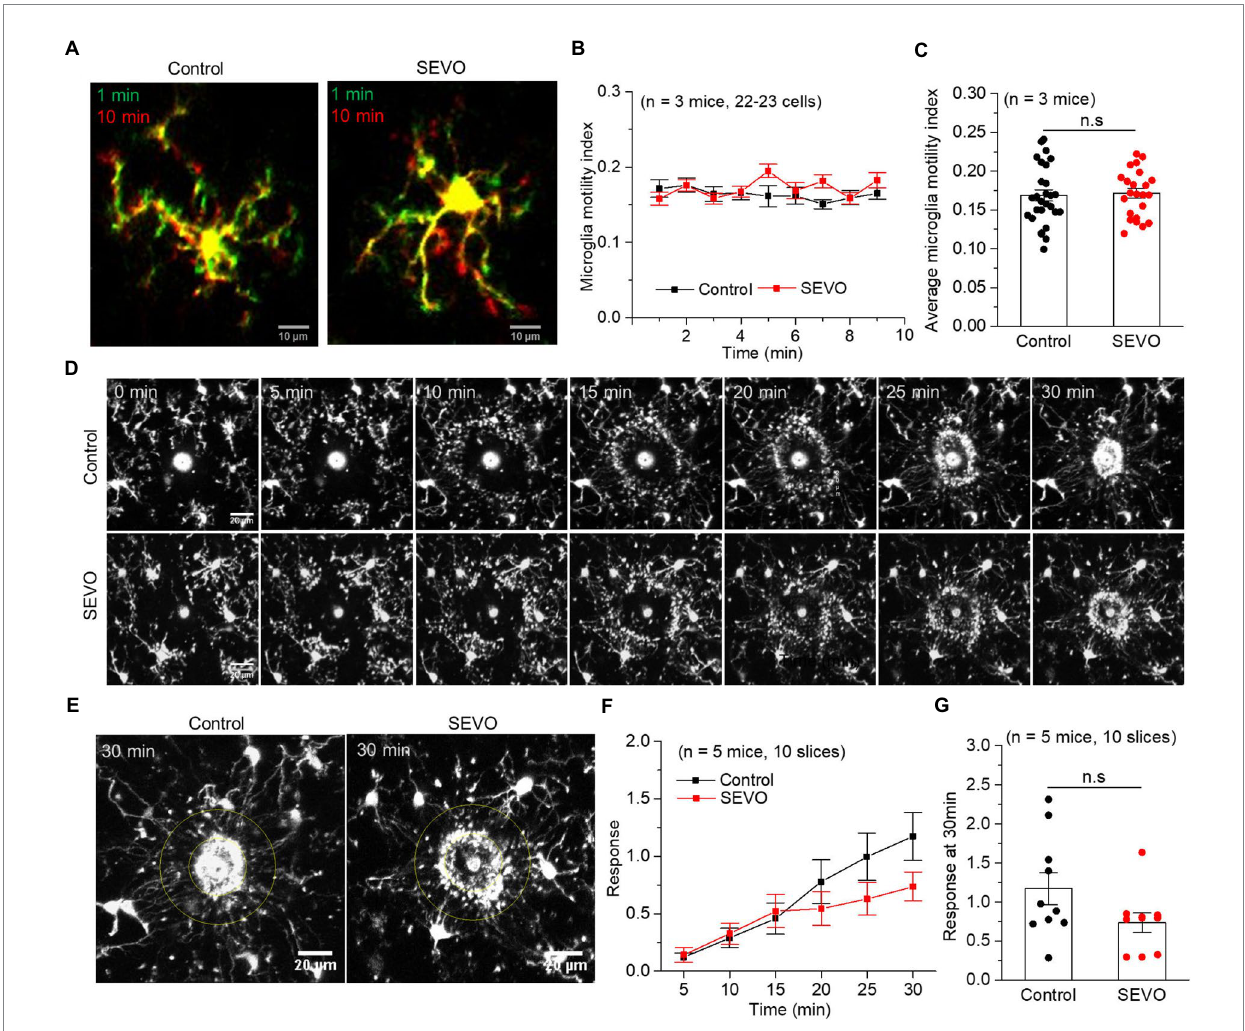
FIGURE 5 Microglia surveillance capability in resting and stimulated states 14 days after prolonged neonatal sevoflurane exposure. (A) Representative images of microglia in acute brain slices of CX3CR1-EGFP mice during 10-min imaging in the resting state 14 days after prolonged sevoflurane exposure. Green represents microglia at 1 min, red represents microglia at 10 min, and yellow represents the part without morphological change at 10 min compared to 1 min. (B) Microglia motility index analysis during 10 min imaging in the resting state. (C) Quantification of average microglia motility index during 10- min imaging in the resting state ( p = 0.772, two-sample t -test). (D) Representative images of microglia response to laser burn injury within 30 min in acute brain slices of CX3CR1-EGFP mice 14 days after prolonged sevoflurane exposure. (E) Representative images of microglia in acute brain slices of CX3CR1-EGFP mice at 30 min after laser burn injury. (F) Response index of microglia within 30 min after laser burn injury of acute brain slices of CX3CR1-EGFP mice. (G) Quantification of response index of microglia at 30 min after laser burn injury of acute brain slices of CX3CR1-EGFP mice ( p = 0.090, two-sample t -test). Data are shown as mean ±